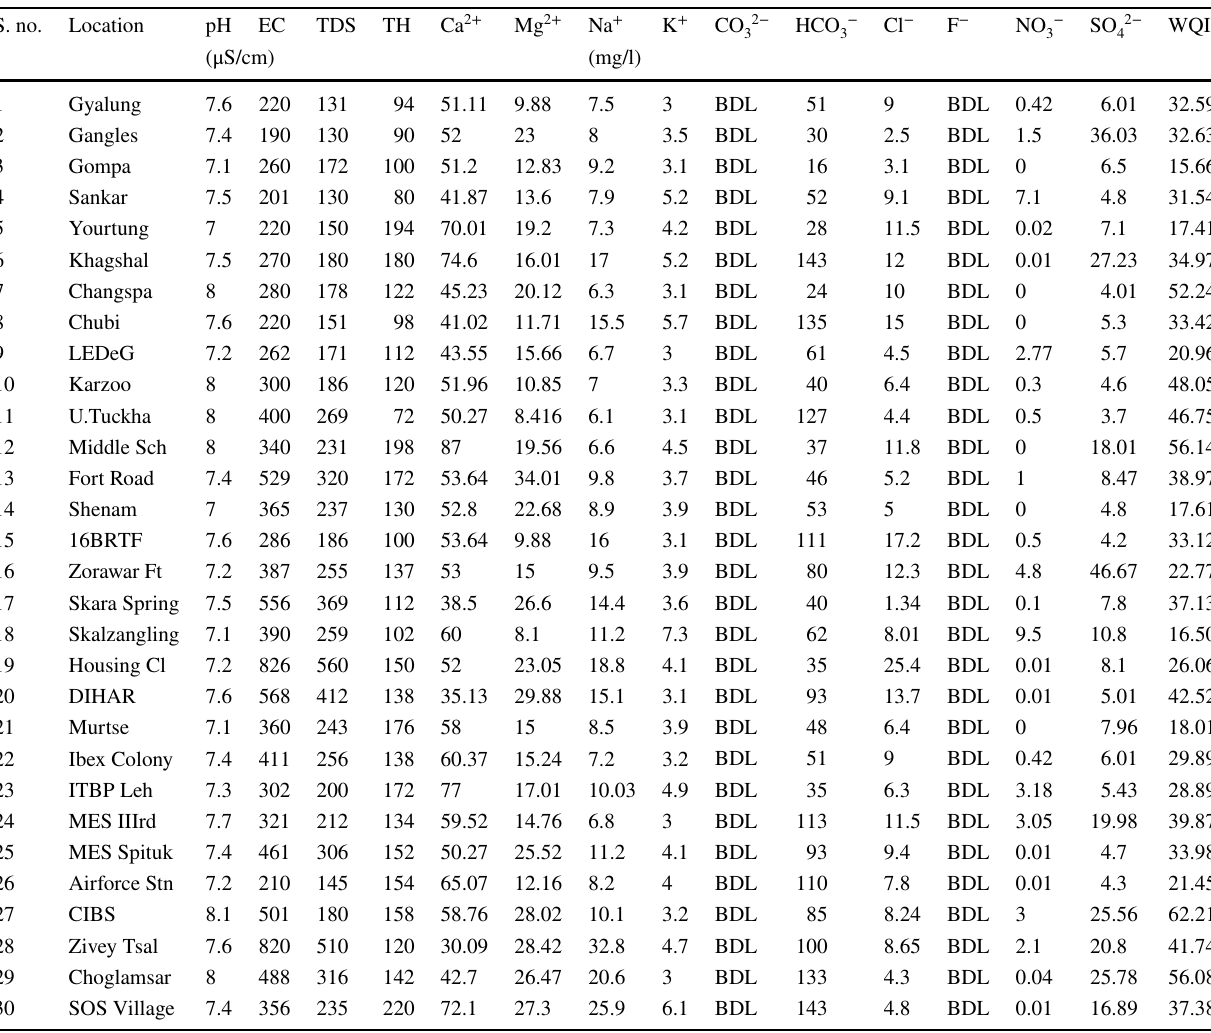
Table 2 Results of groundwater sample analysis during post-monsoon/post-tourist season